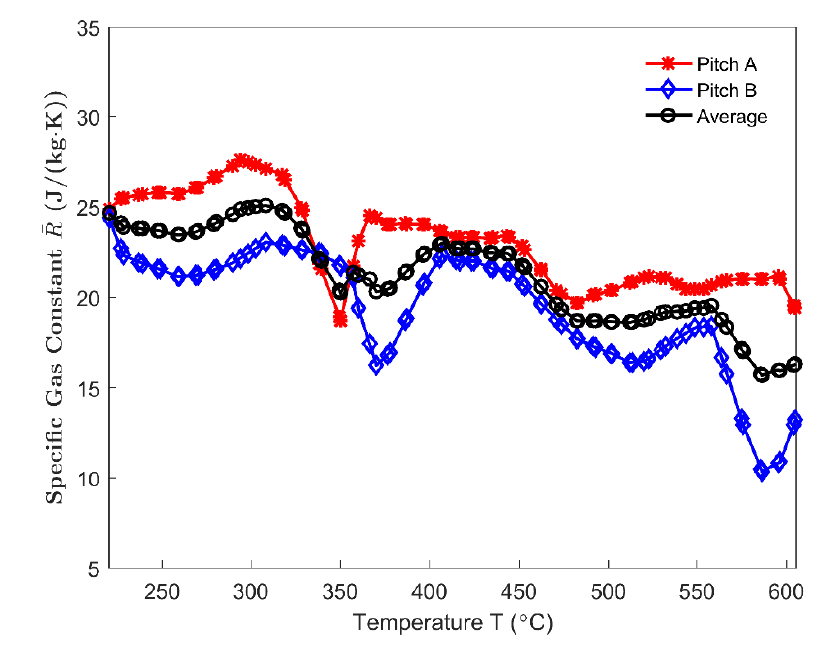
Figure 21. Specific gas constant from 220 °C to 605 °C.